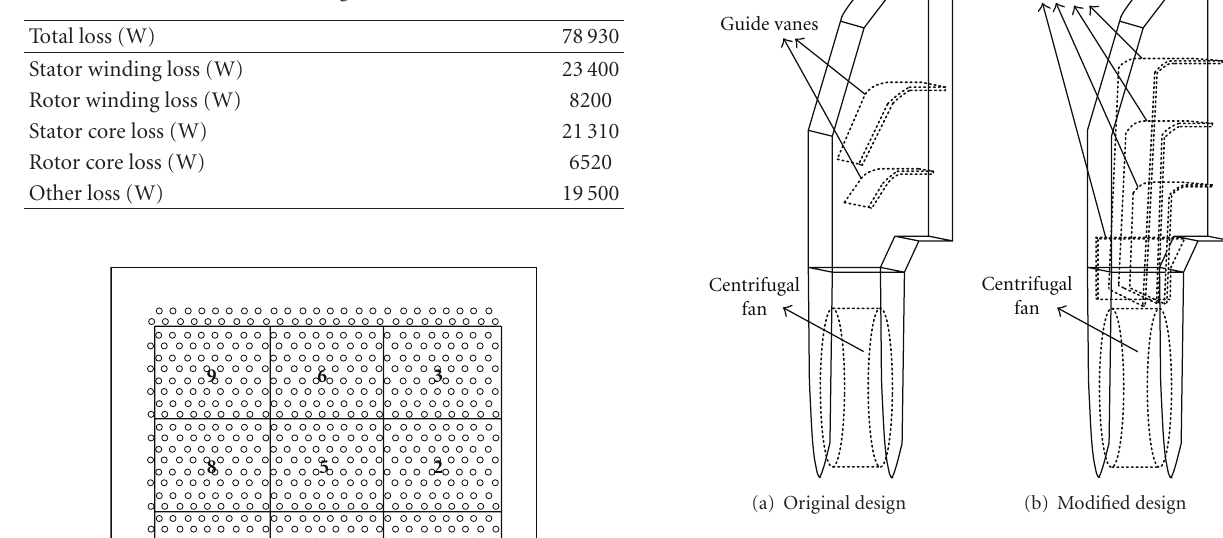
Figure 6: Guide vanes with (a) original design and (b) modified design.